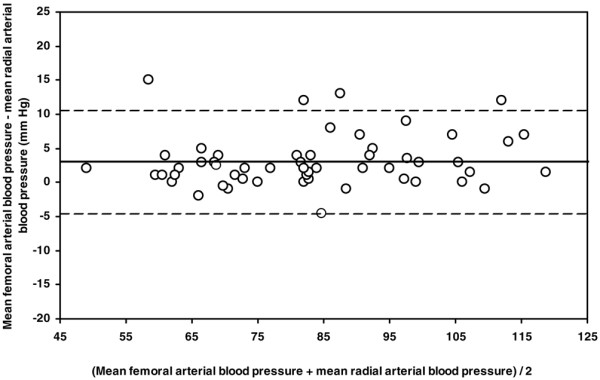
Plot of differences against averages of simultaneous measurements of femoral and radial mean arterial blood pressures. The solid line represents bias (the mean difference between simultaneous measurements). Dotted lines show 95% limits of agreement (bias ± 1.96 standard deviation). The small bias (mean difference between simultaneous measurements) and the narrow 95% limits of agreement suggest the interchangeability of both measurements.